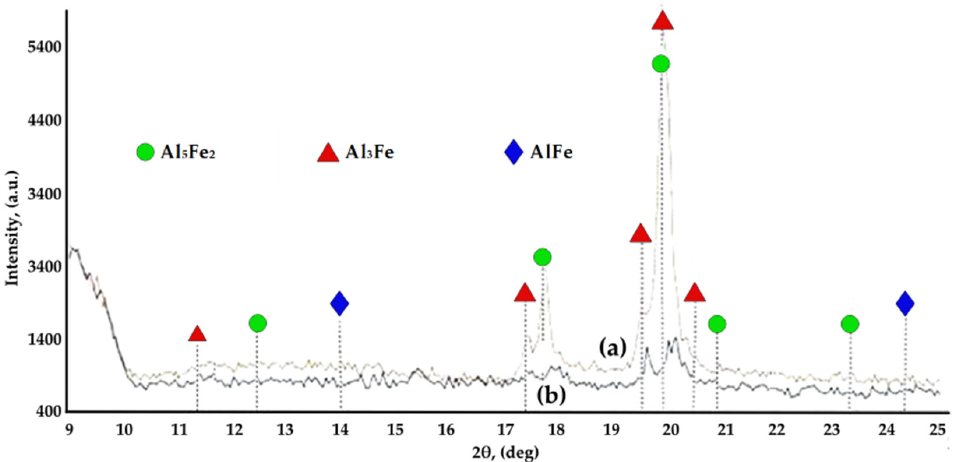
Figure 9. X-ray diffraction analysis, after the pack cementation process (900 ◦ C/5 h), of the specimens from the two compositions used as active components: ( a ) FeAl40 powder; ( b ) the mixture of Al and Fe powder in equal proportions by